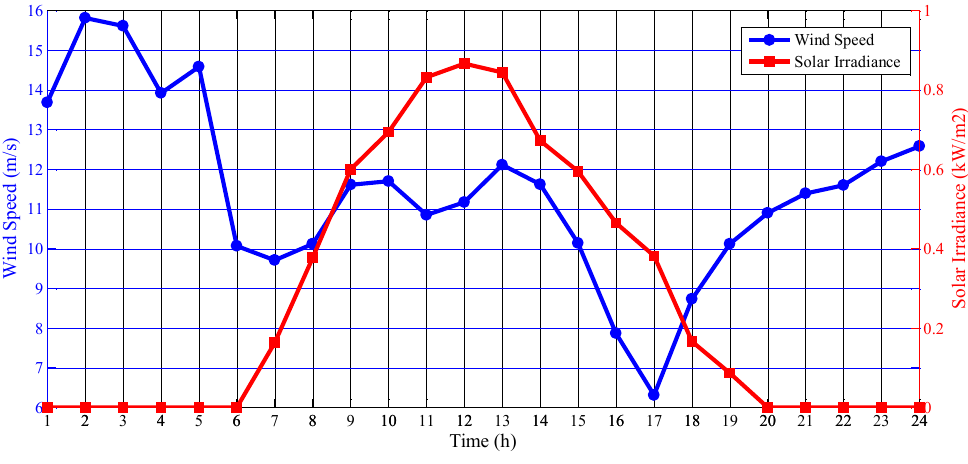
Figure 6. Wind speed and solar irradiance forecast.